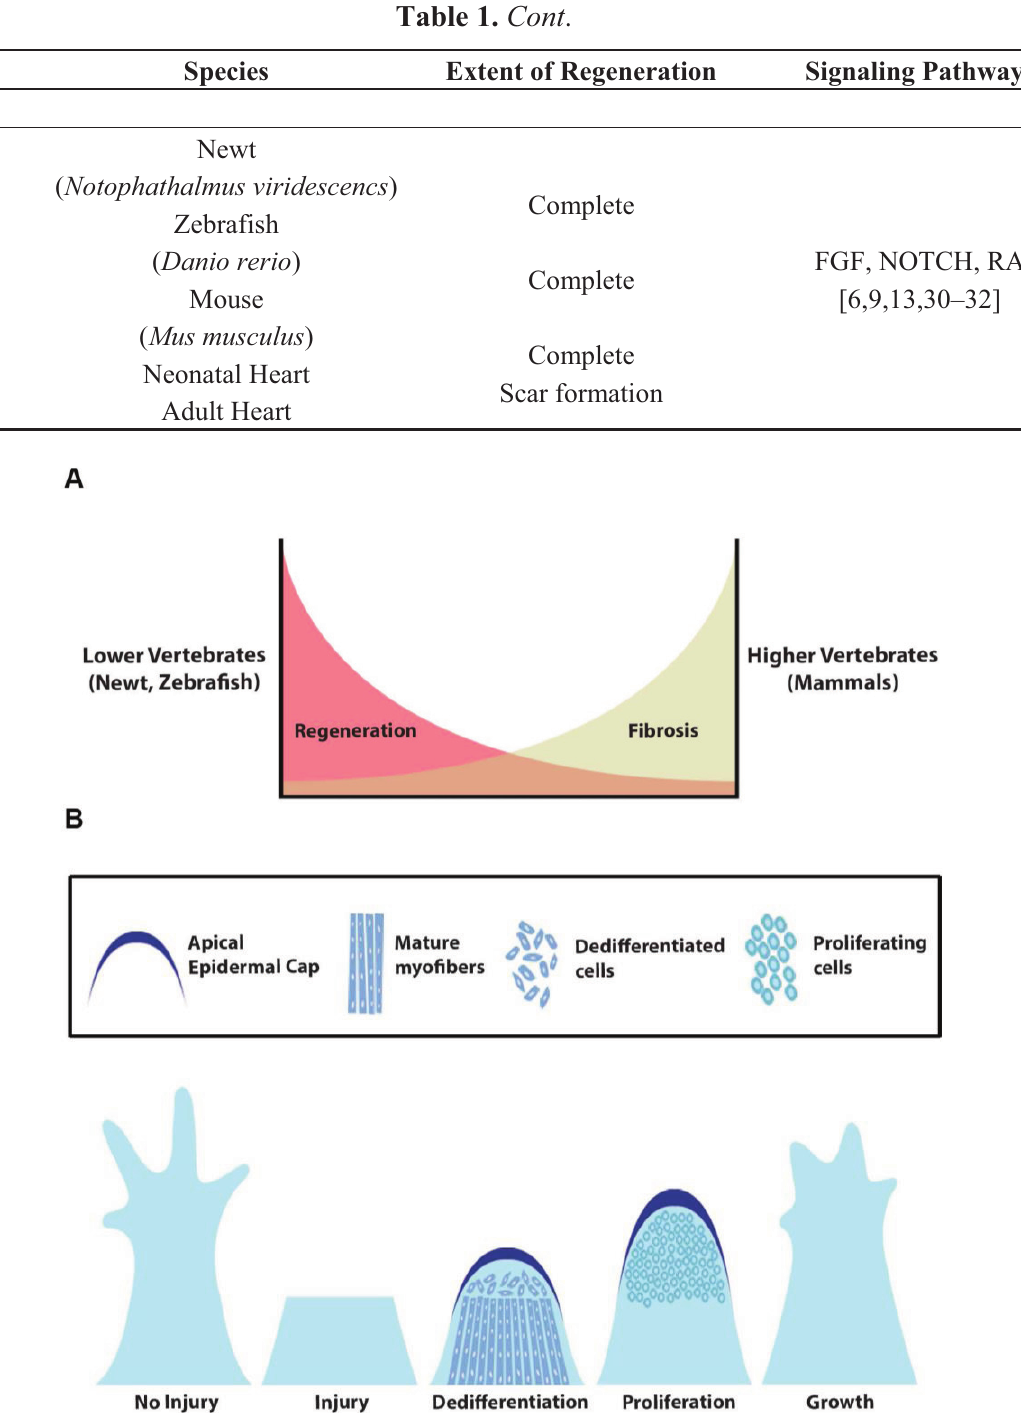
Figure 1. Regeneration and scar formation. ( A ) Lower vertebrates (newt and zebrafish) have tremendous potential to regenerate with minimal scar formation. In contrast, higher vertebrates (mammals) have a restricted regenerative ability marked by increased fibrosis and scar formation; ( B ) In the regenerative systems, tissue regeneration occurs in multiple steps including wound healing, dedifferentiation, proliferation, growth and